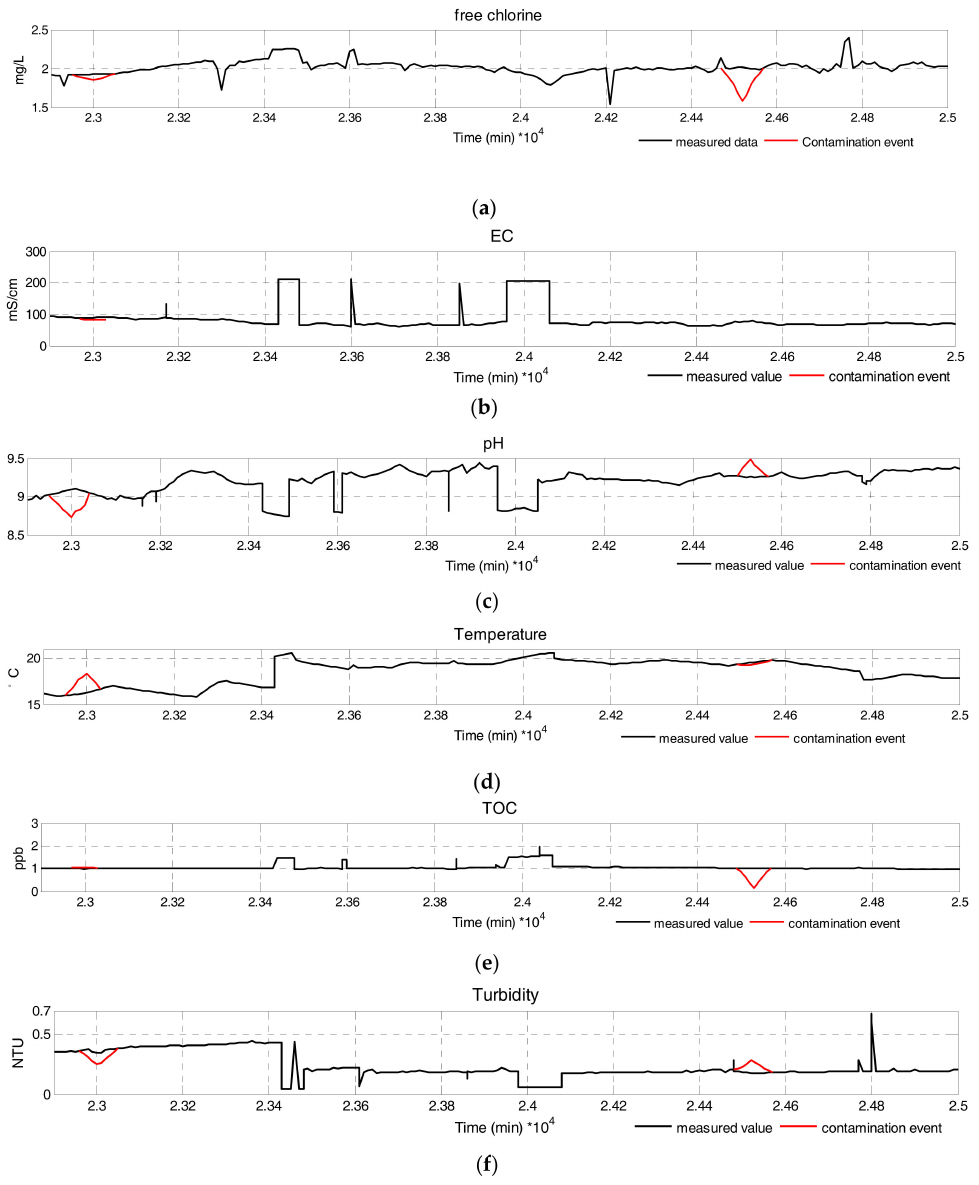
Figure 8. Time series of multivariate water quality parameters. ( a ) Free Chlorine; ( b ) EC; ( c ) pH; ( d ) Temperature; ( e ) TOC; ( f )